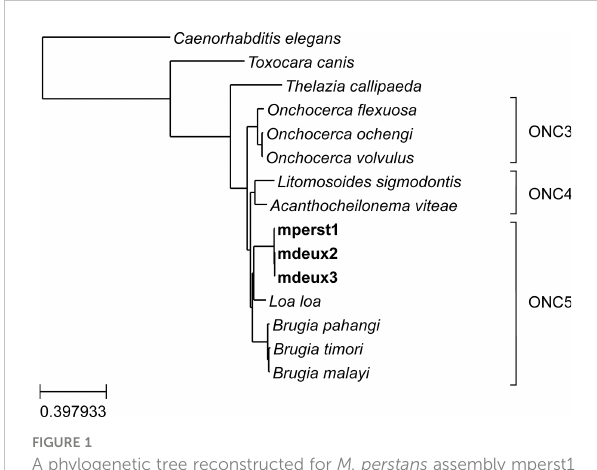
FIGURE 1 A phylogenetic tree reconstructed for M. perstans assembly mperst1 and the two Mansonella sp “ DEUX ” assemblies mdeux2 and mdeux3, including 12 other nematode species based on the concatenation of 562 protein alignments. Onchocercidae clades ONC3, ONC4 and ONC5 are shown next to the corresponding species.